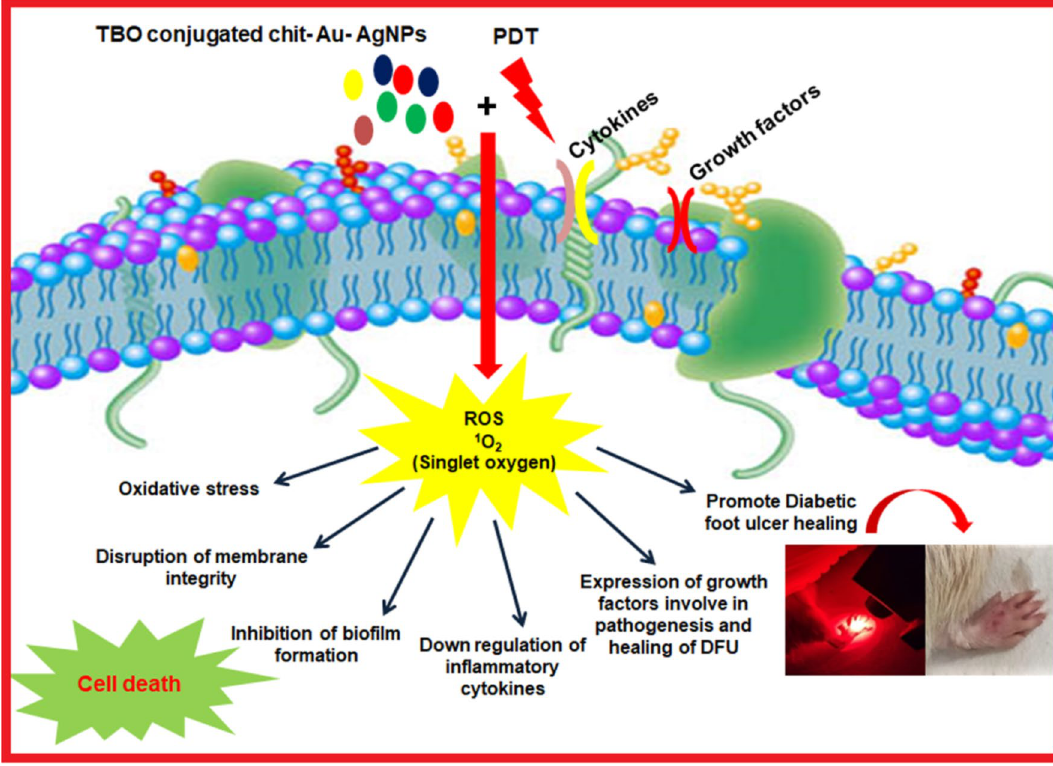
Figure 1. Schematic representation of nanoparticle mediated antimicrobial photodynamic therapy against diabetic foot